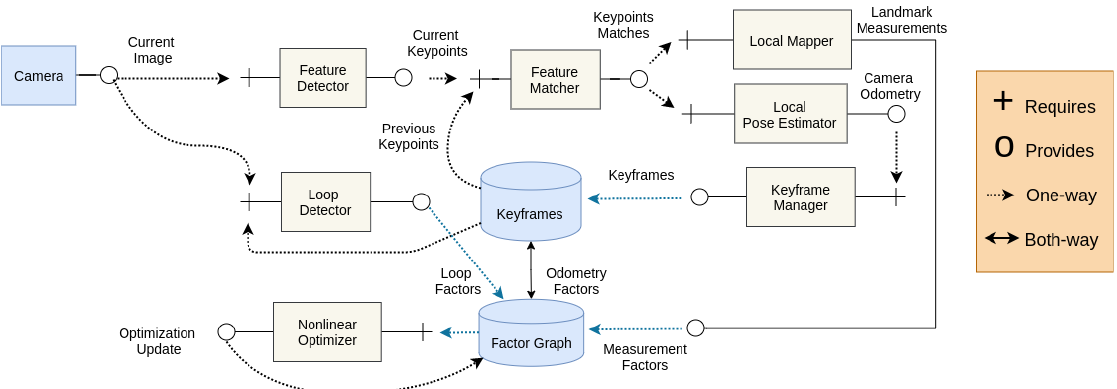
Figure 2. Architecture for VSLAM showing components (active and passive), interfaces, and data flow with appropriate message